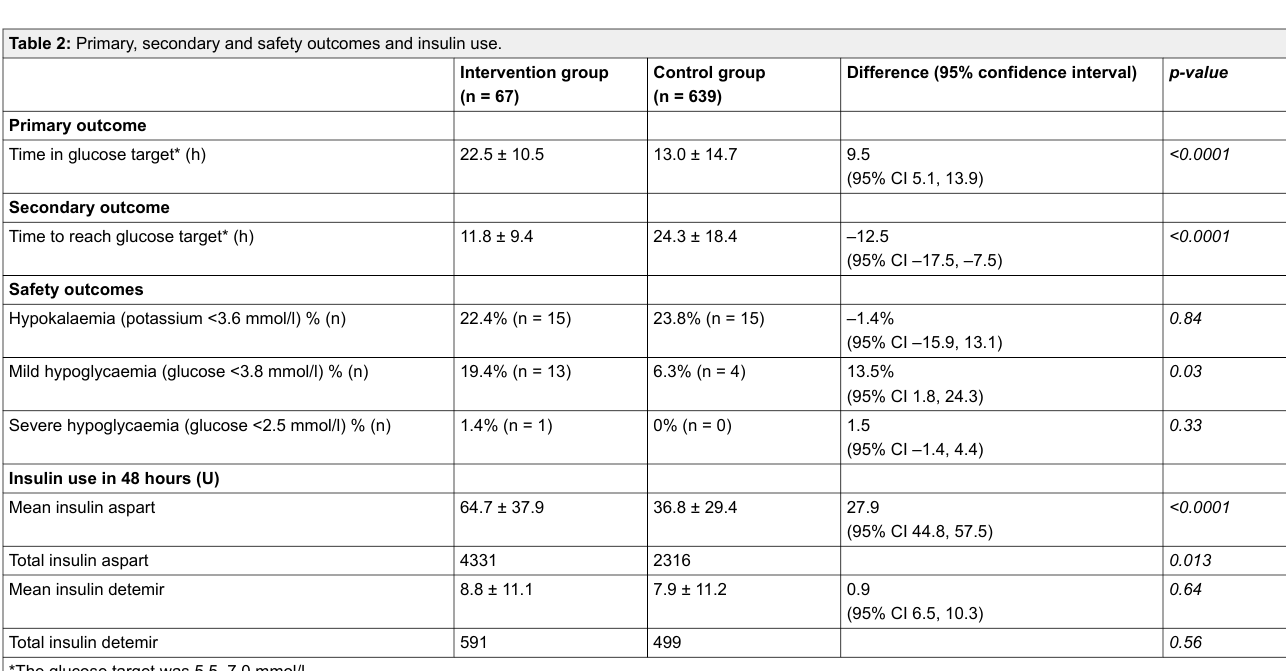
Table 2: Primary, secondary and safety outcomes and insulin